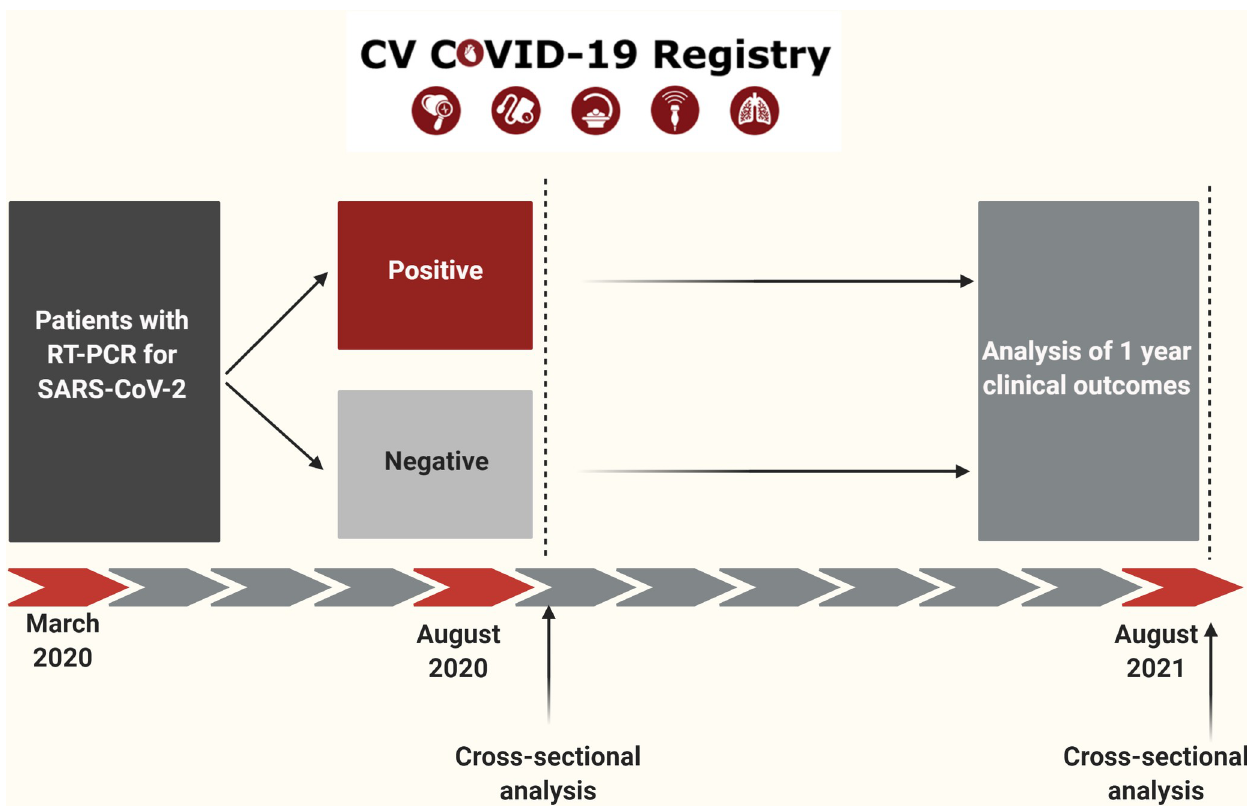
Fig 1. Timeline of the study. Inclusion of the patients will be since March to August 2020. Analysis of the clinical outcomes will be performed in August 2021.